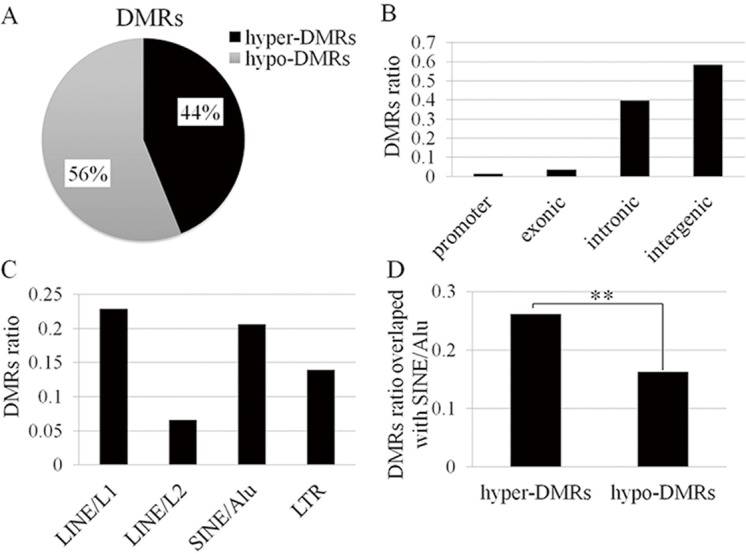
DMRs ratio.(A) The percentage of hyper-DMRs and hypo-DMRs. (B) DMRs ratio overlapped with different genomic sequences. (C) DMRs ratio overlapped with different repeat elements. (D) The hyper-DMRs are preferentially overlapped with SINE/Alu repeat compared with hypo-DMRs (** p < 0.01).